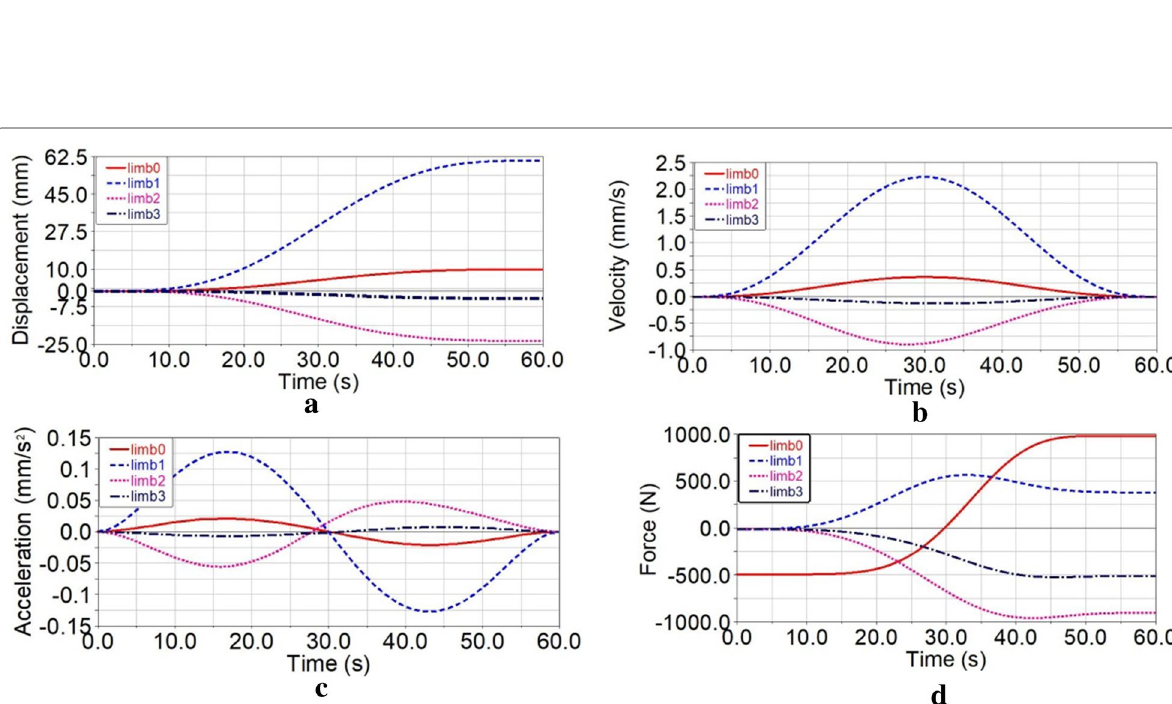
Figure 11 a Displacement, b velocity, c acceleration, and d driving force of each limb of module